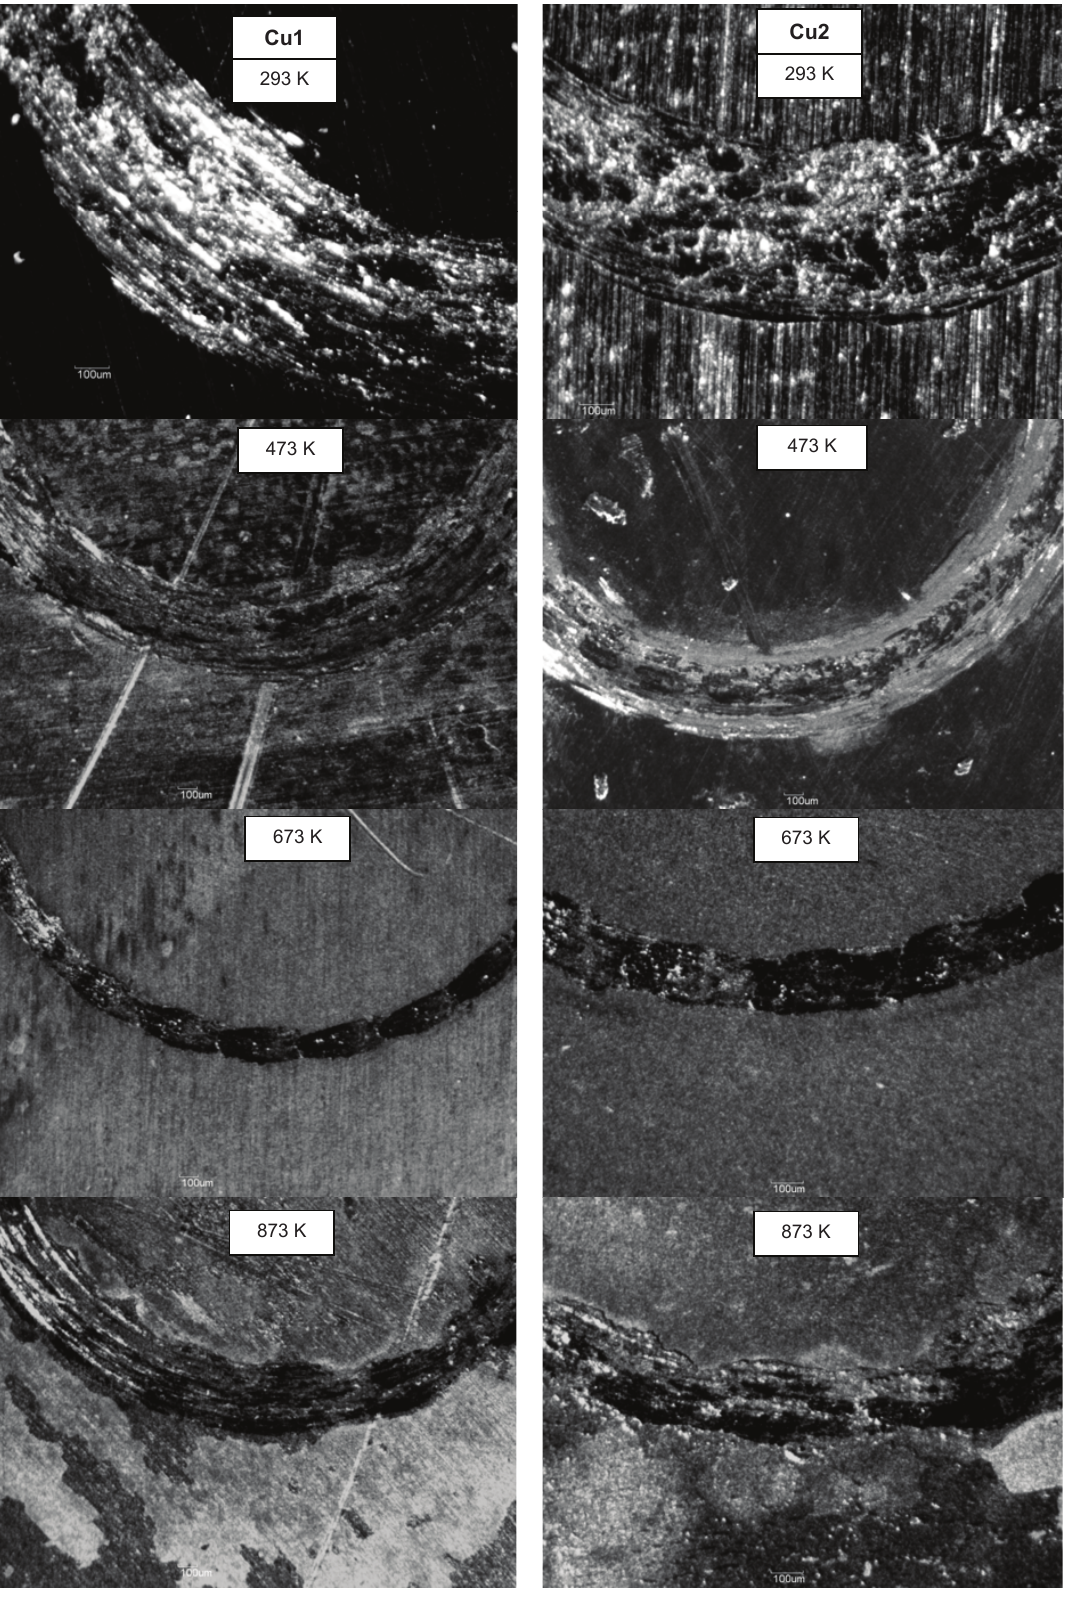
Figure 5. Wear tracks in Cu-Al 2 O 3 composites made at various temperatures. Cu1 – left column, Cu2 – right